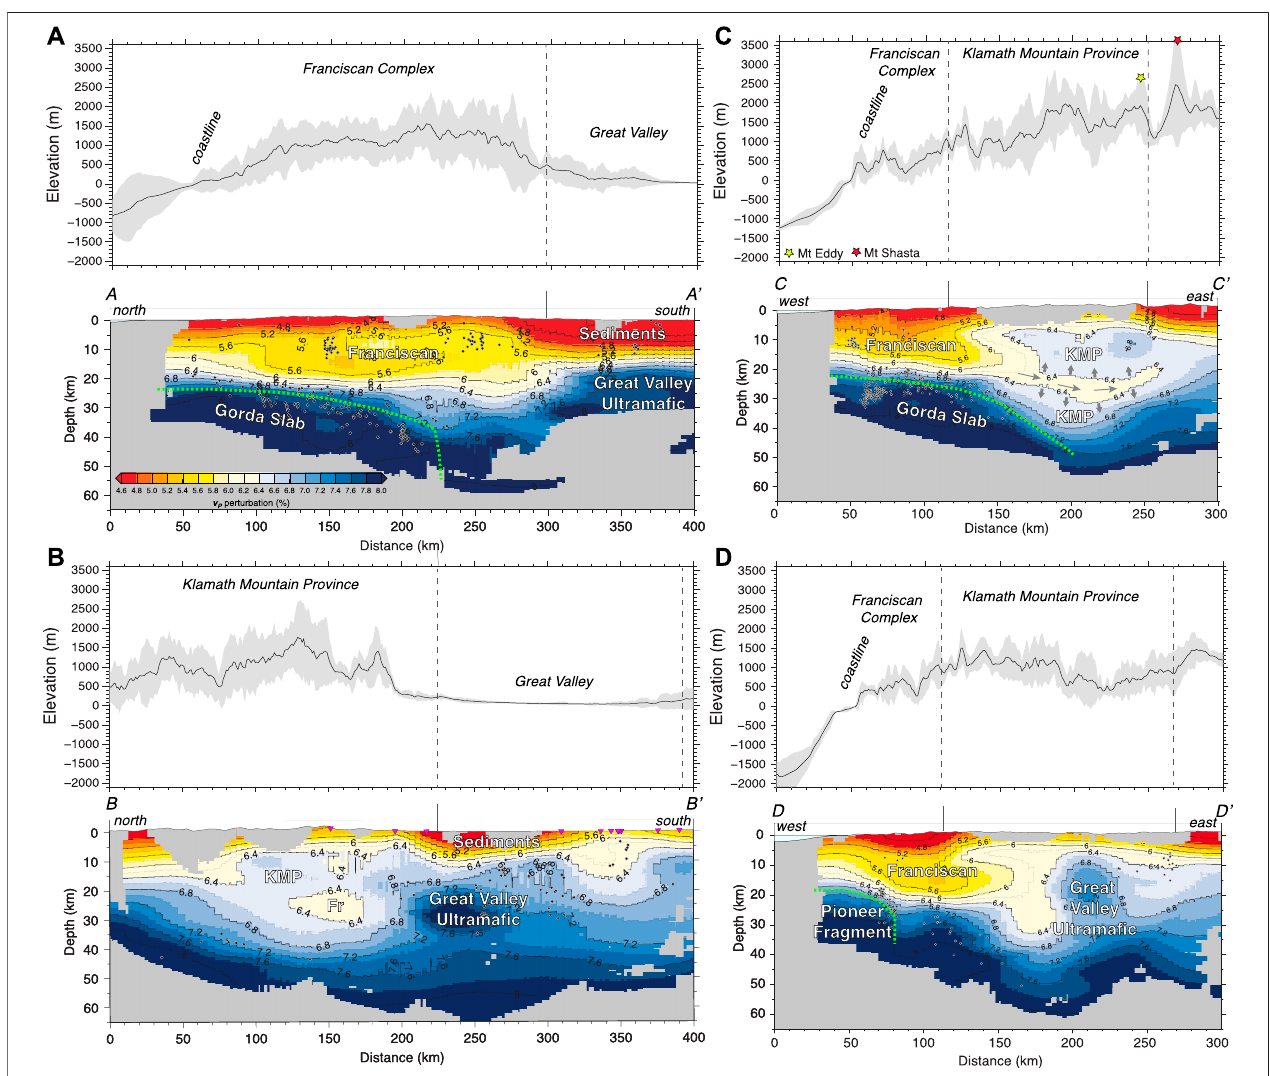
FIGURE9| Seismictomographycrosssections (A – A 9 ,B – B 9 ,C – C 9 ,D – D ’ ) .Topographicswathpro fi lesforeachcross-sectionareshownabove.Theswathsused in the topographic pro fi les are shown in Supplementary Figure S3 . Cross section lines are shown in Figures 8 , 10 . The green dashed line shows the approximate extent of the Gorda slab and Pioneer fragment beneath North America. The approximate locations of the surface boundaries for the geologic terranes are labeled at the top of each cross